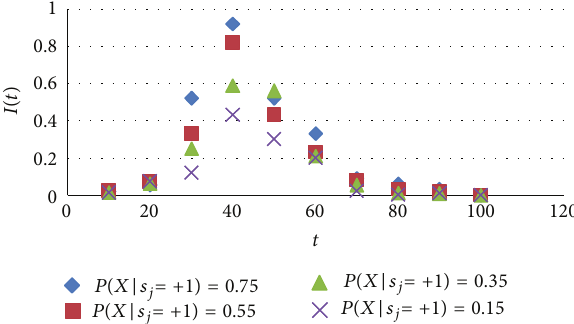
Figure 5: Identity views impact on information dissemination.